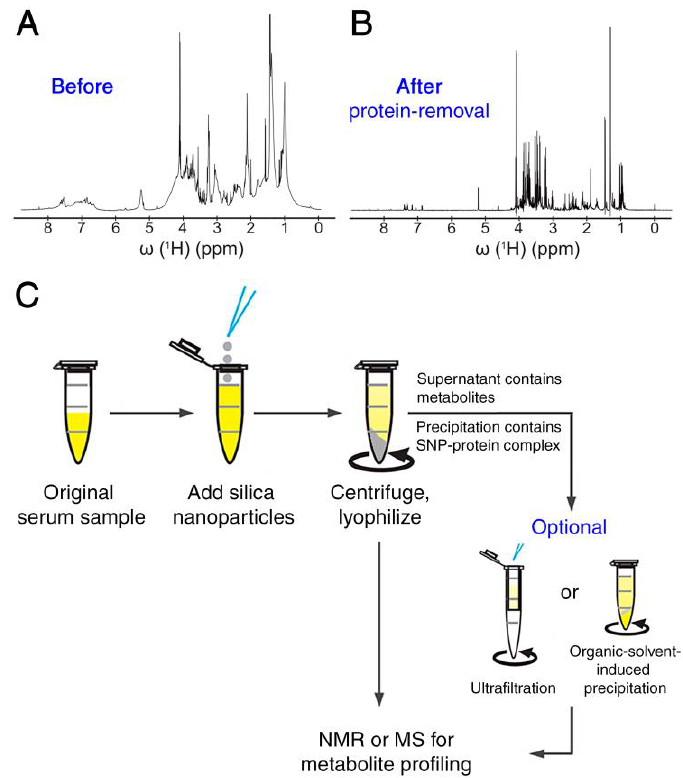
Figure 1. Protein removal from serum samples using silica nanoparticles for metabolomics studies. 1 H-NMR spectra of metabolites in pooled human serum ( A ) before and ( B ) after removing proteins using silica nanoparticles. ( C ) The general workflow is depicted, which is efficient, cost effective and